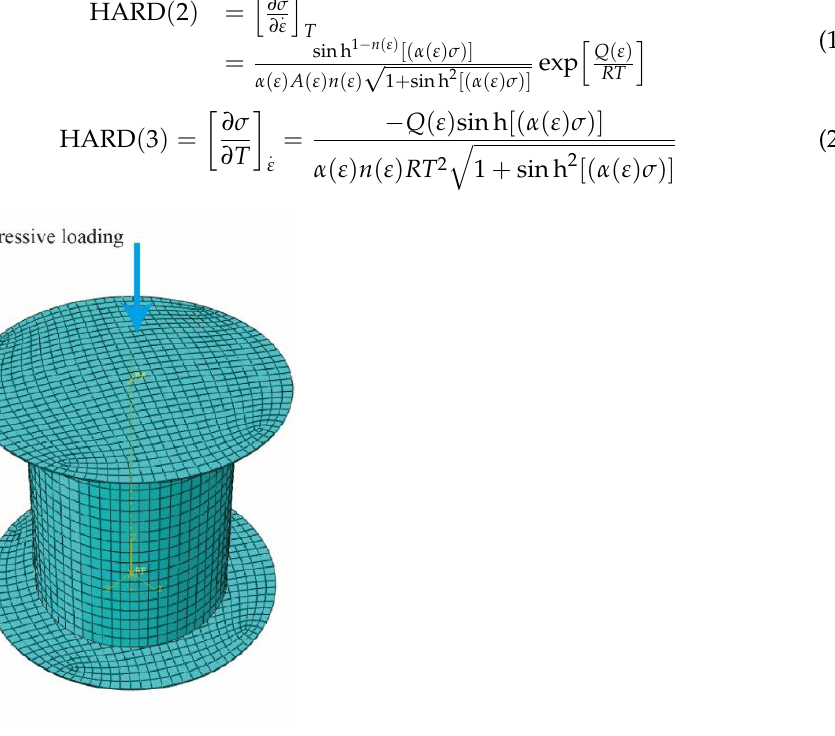
Figure 12. Grid model of the sample.